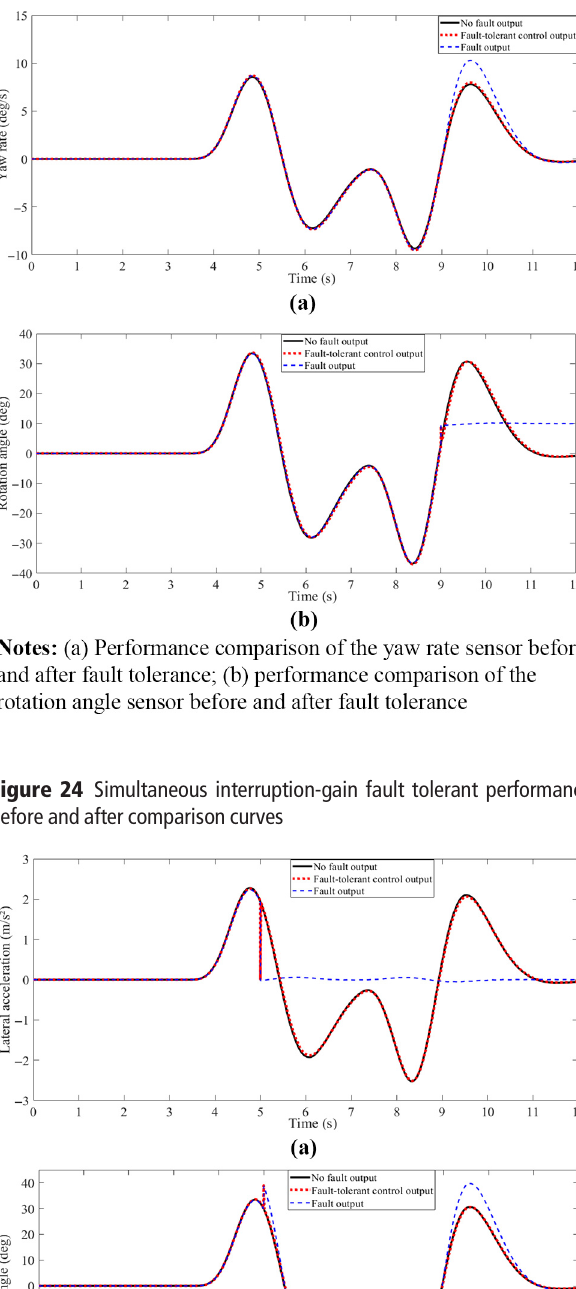
Figure 23 Simultaneous gain-stuck fault tolerant performance before and after comparison